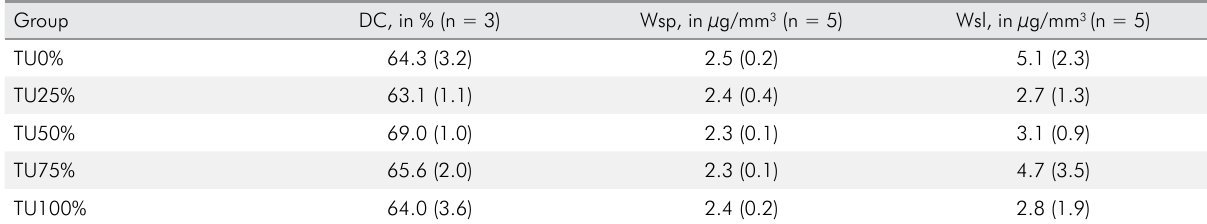
Table 2. Mean of and standard deviations of degree of conversion (DC), water sorption (Wsp) and solubility (Wsl).